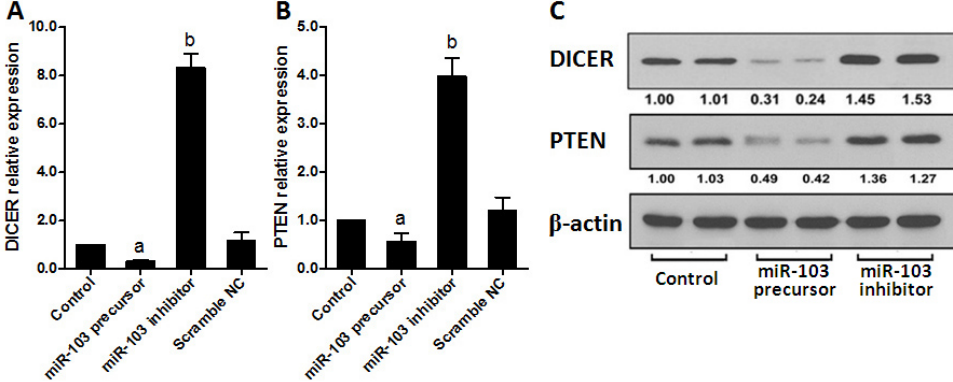
Figure 4. miR-103 regulates DICER and PTEN expression in colorectal cancer cells. ( A , B ) mRNA levels of DICER and PTEN were determined by real-time PCR in transfected HCT-116 cells; and ( C ) Western blots were used to confirm the expression of DICER and PTEN in HCT-116 cells after transfection and β -actin was used as control. Data are representative of three experiments. Error bars represent as mean ± SD. a p < 0.05; b p < 0.01 vs. control.